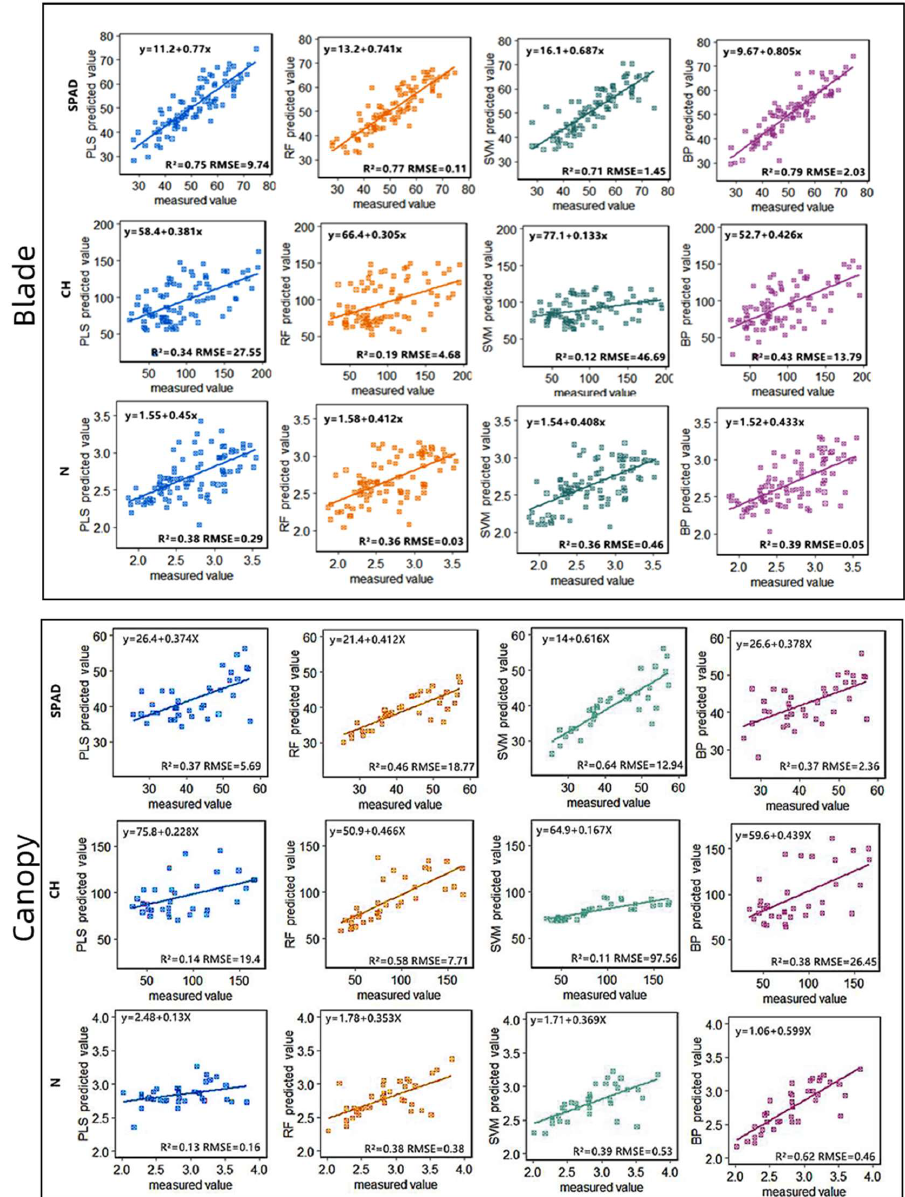
Figure 11. Accuracy comparison of various algorithm models at leaf and canopy scale. SPAD represents the value measured with the spad-502 plus instrument, CH represents the total chl, N represents the nitrogen.